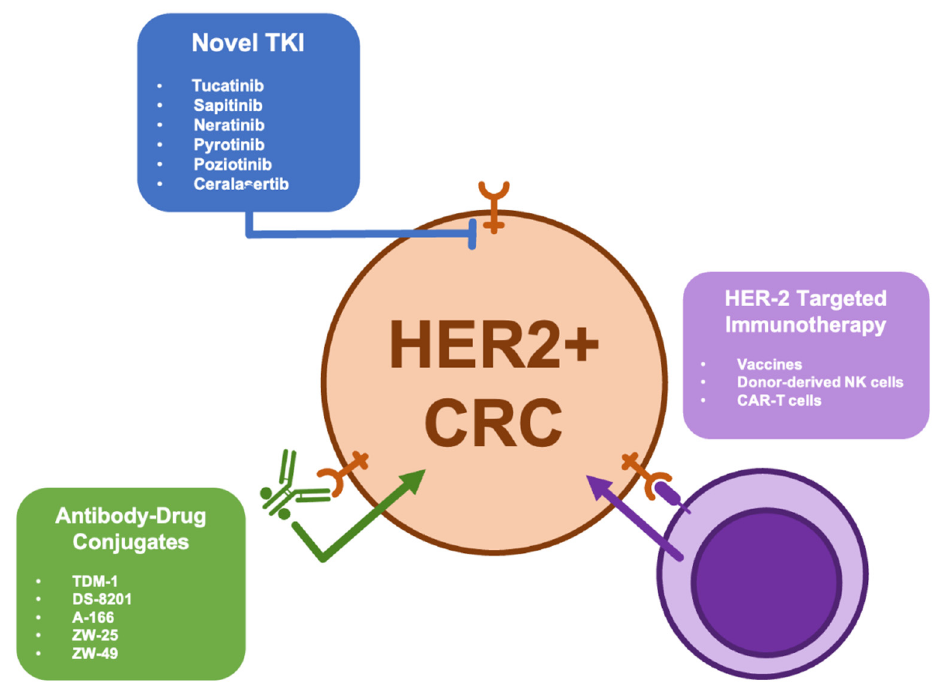
Figure 2. Novel therapeutic strategies for HER-2 positive colorectal cancer.